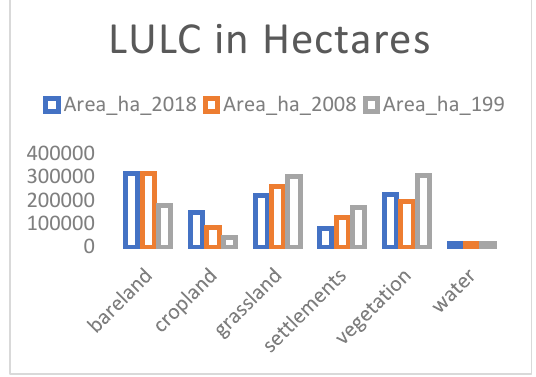
Figure 2: Three maps showing 1999, 2008 and 2018 Random Forest